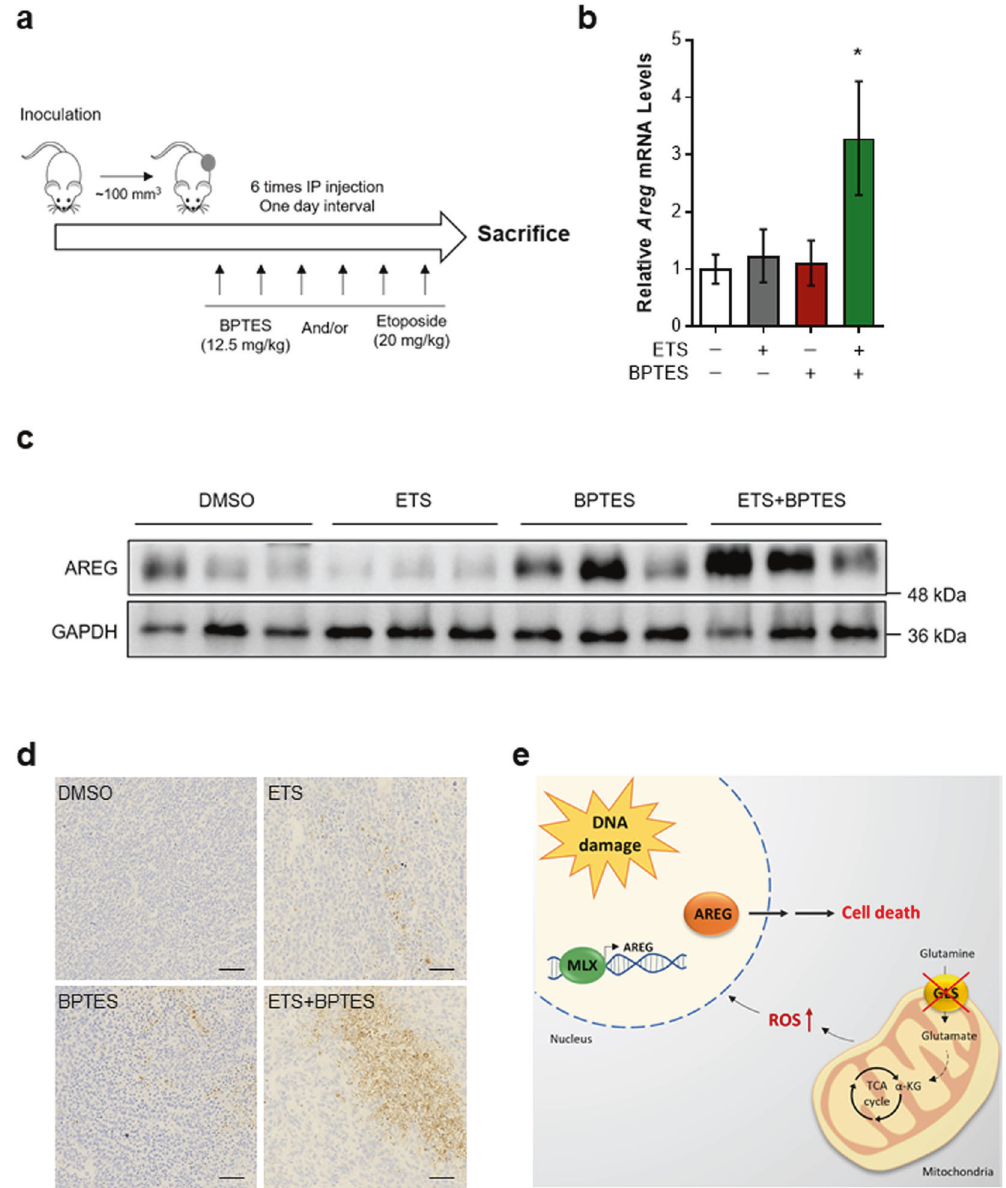
Fig. 6 The combination of GLS inhibition with chemotherapeutic agents is effective to induce cell death in tumors. a Animal experiment schedule. Mice were injected subcutaneously with transformed MEFs. Drugs were administered as indicated. A day after the treatment, mice were sacri fi ced and tumors were collected. b, c Relative AREG mRNA ( b ) and protein ( c ) levels in allograft tumors from mice treated with or without ETS, BPTES, or both ( n = 3). d Immunohistochemical analysis of cleaved caspase-3 expression in allograft tumors. Scale bars represent 50 µm. e A proposed model illustrating the regulation of DNA damage-induced cell death by mitochondrial Gln metabolism. All error bars ± SEM. * p < phenotypes. In this study, we demonstrate that pharmacological anaplerosis determines sensitivity of cancer cells to chemother- interference in Gln anaplerosis unequivocally resulted in increased apeutic drugs, highlighting the potential importance of this cell death after DNA damage. Because an inadequate elimination pathway in cancer therapy. Our studies, therefore, uncover of DNA damaged cells often leads to the accumulation of the role of mitochondrial Gln metabolism in determining the chromosomal instability and tumor development, our study and survival-death cell fate decision in response to DNA damage the one by Jeong et al. reveal that the repression of mitochondrial with important implications for cancer treatment. Gln metabolism in response to genotoxic stress is an important Our fi ndings are consistent with previous work showing that the cellular metabolic checkpoint for sustaining genomic stability and repression of mitochondrial Gln metabolism is required for proper preventing tumorigenesis. cellular DNA damage response [10]. Jeong et al. (2013) found that Although our work shows that the regulation of AREG by DNA damage triggers a block in the entry of Gln into the TCA Gln anaplerosis is critical for DNA damage-induced cell death, it cycle, which is required for the DNA damage responses such as does not exclude the involvement of other Gln-dependent cell cycle arrest and DNA repair, and defects of this lead to DNA pathways that may contribute to cell survival upon DNA damage. damage-induced genomic instability, resulting in tumorigenic